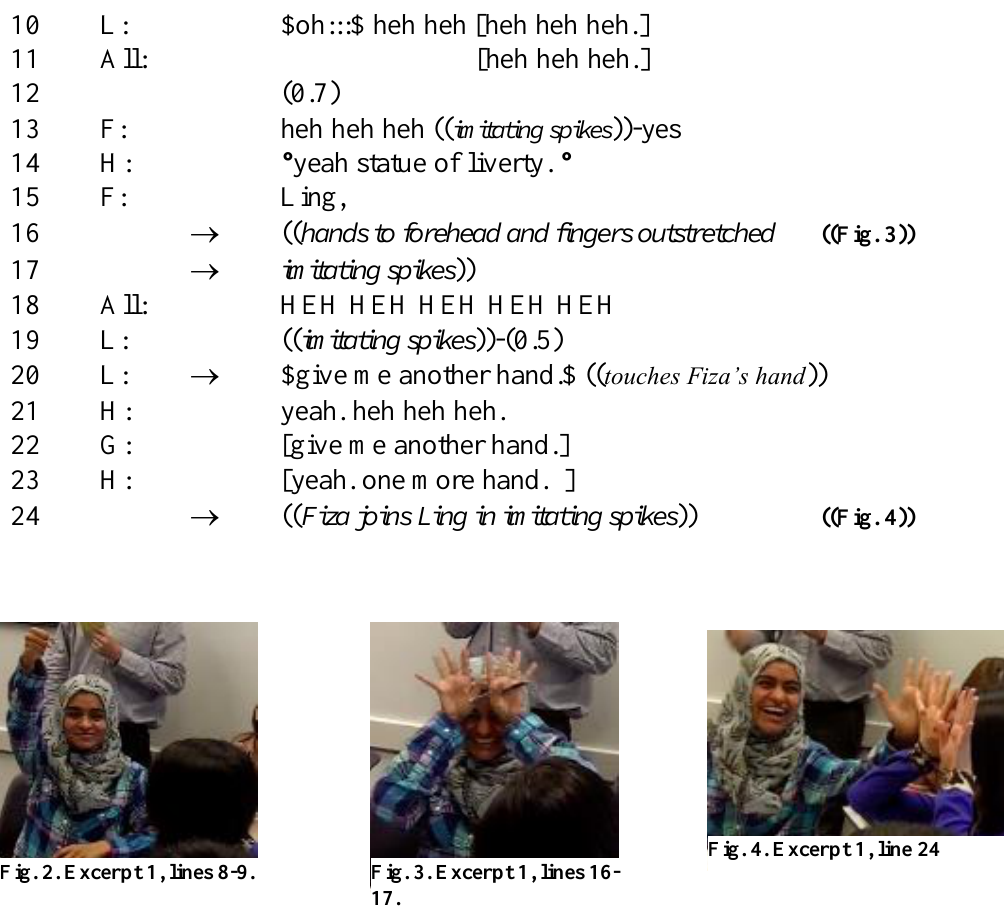
Fig. 4. Excerpt 1, line